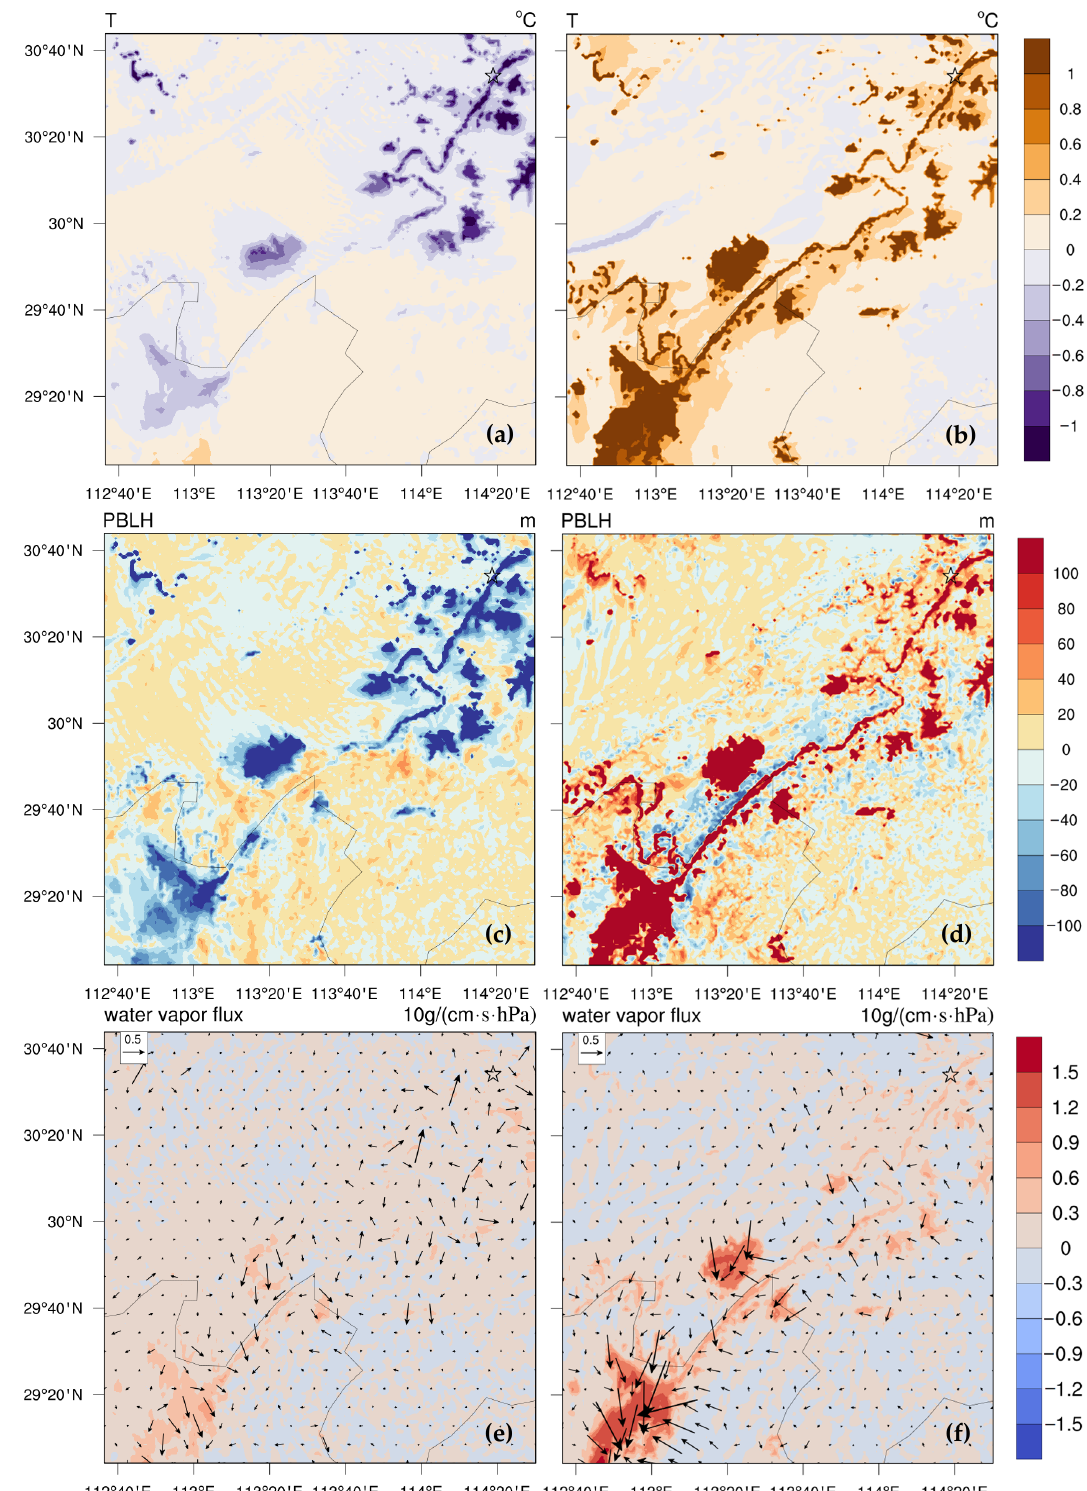
Figure 8. Spatial differences of ( a , c , e ) daytime (14:00 local time) and ( b , d , f ) nighttime (02:00 local time) ( a , b ) 2 m temperature, ( c , d ) atmospheric boundary layer height, and ( e , f ) water vapor flux transport in the horizontal direction between the lake experiment and no-lake experiment during the air pollution process from 19–22 January 2018.